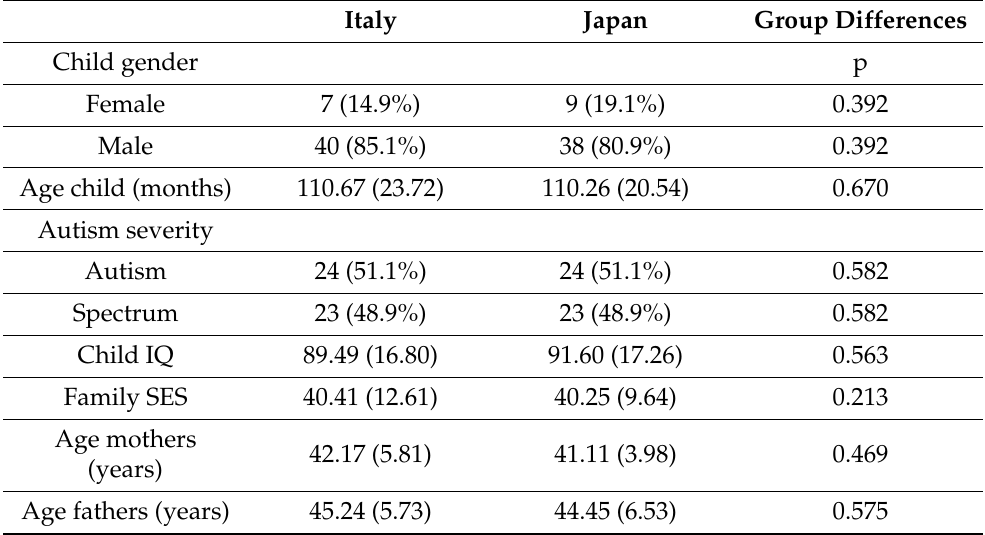
Table 1. Characteristics of the